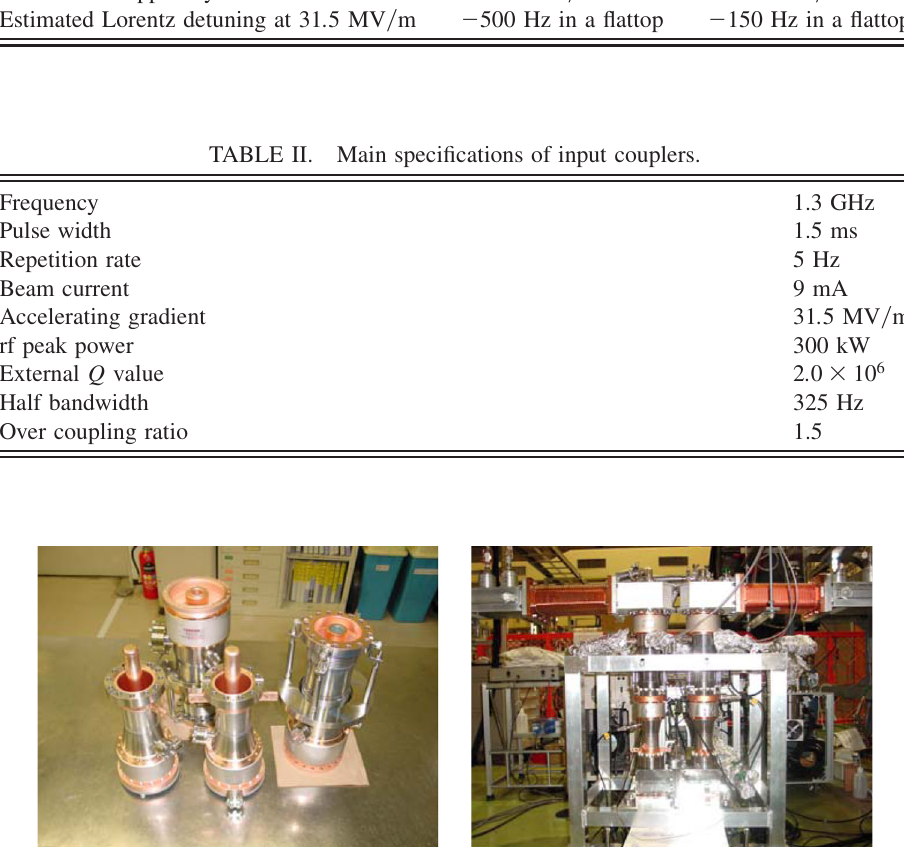
FIG. 3. (Color) Two pairs of input couplers with cold and warm rf windows (left) and setup of high power test stand